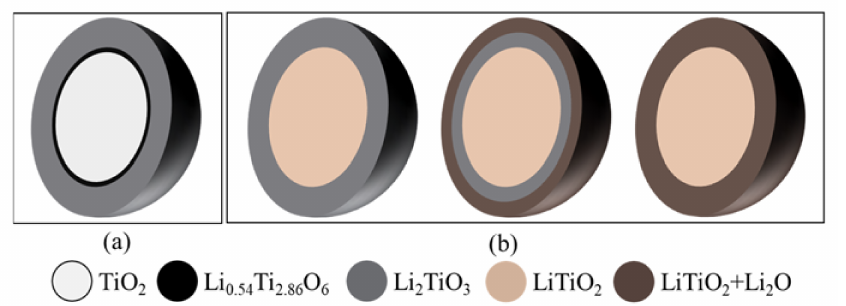
Figure 7. Shrinking core model for ( a ) the TiO 2 soaking process and ( b ) for the electrolytic reduction of the TiO 2 process with a passivation